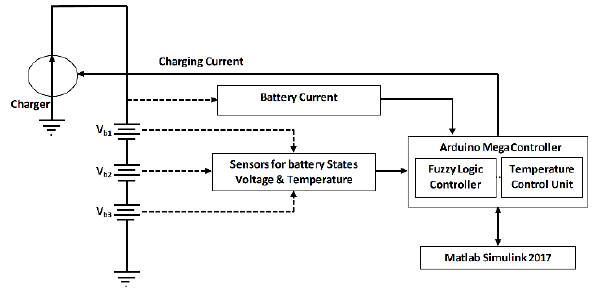
Figure 1. General diagram of the proposed battery-charging system.